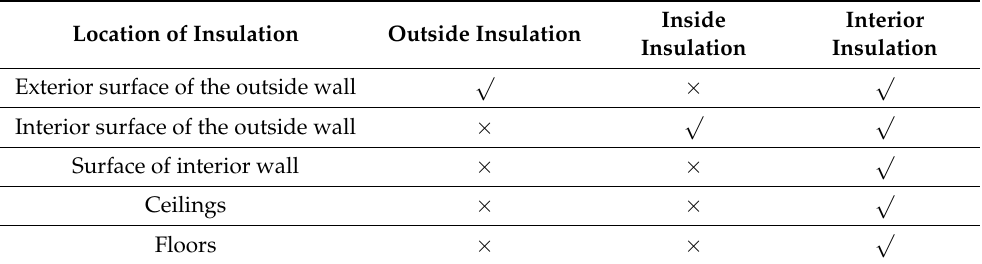
Table 1. Comparison of the three insulation